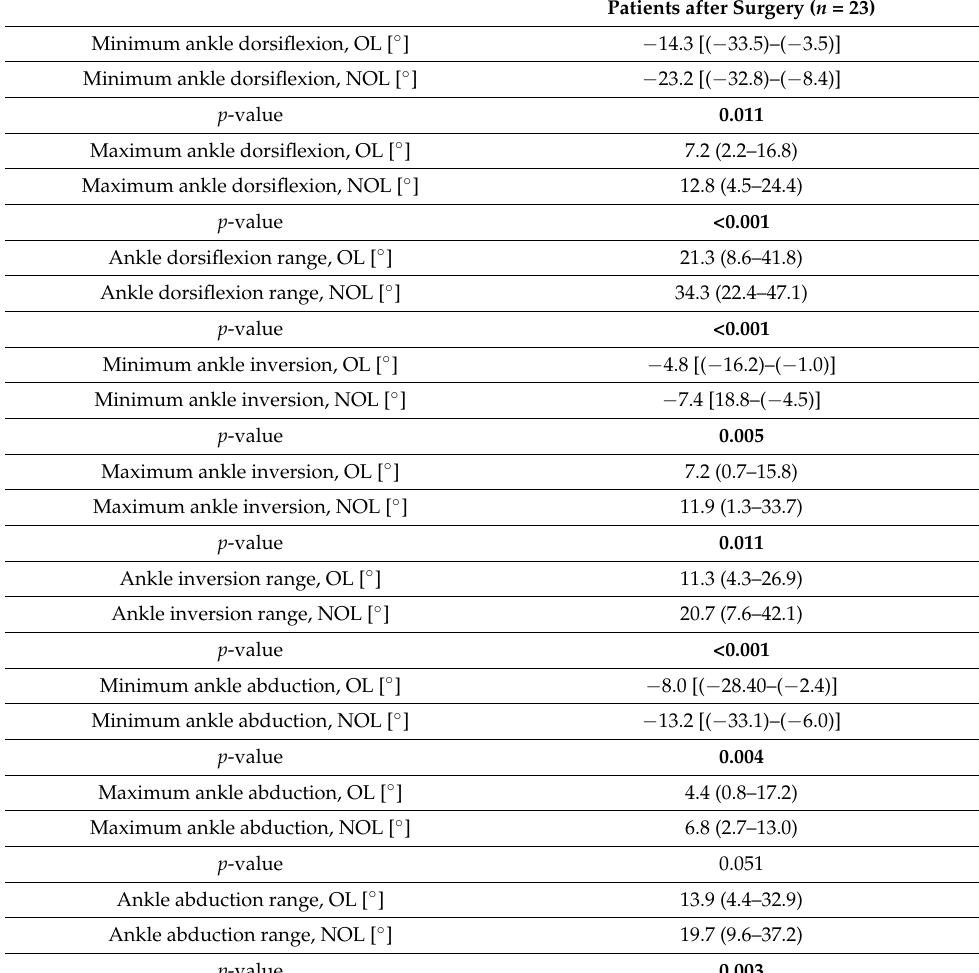
Table 3. Differences in ankle dorsiflexion, inversion, and abduction after Ilizarov